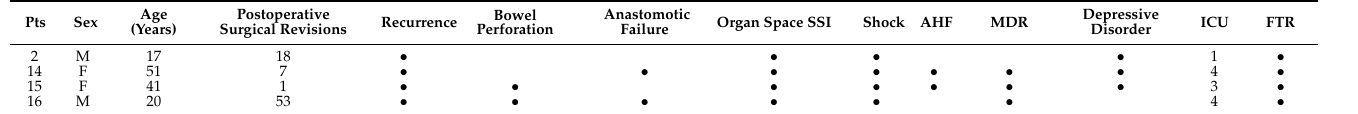
Table 5. Complications in patients who